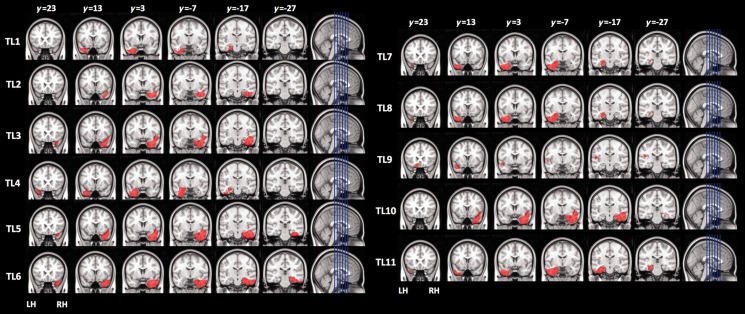
Reconstruction of lesions for each patient in the temporal lobe lesion (TL) group.